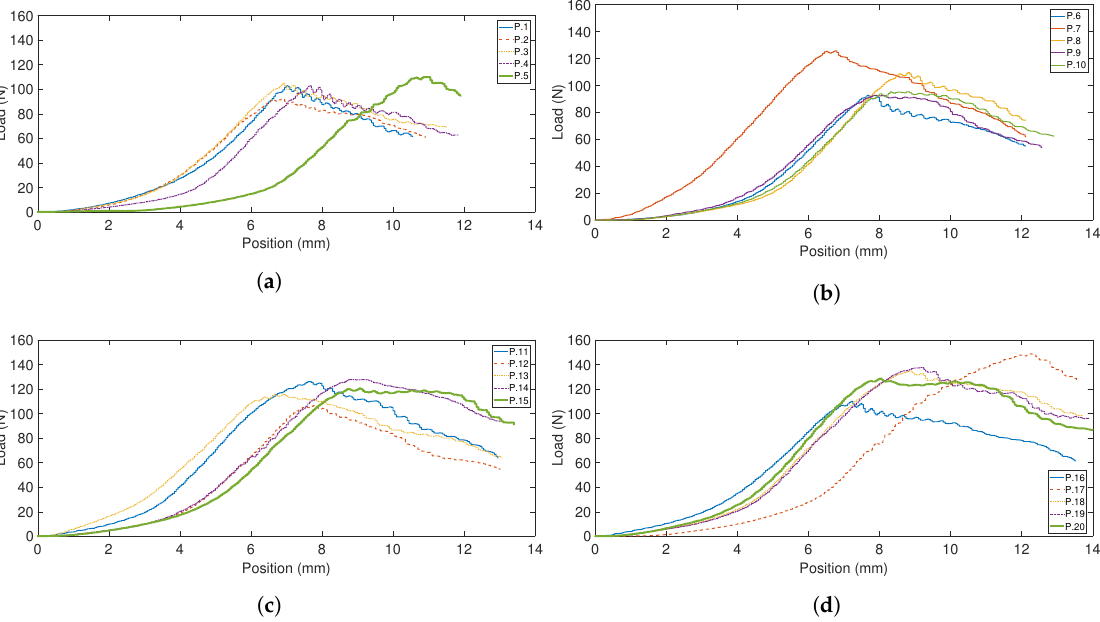
Figure 10. Position-load for a notched blade. Graphs are ordered from lower to higher diameter sizes and P indicates the sample number. ( a ) First quarter of peduncles tested. Sample diameters ranging from 8.56 to 9.95 mm. ( b ) Second quarter of peduncles tested. Sample diameters ranging from 10.11 to 10.94 mm. ( c ) Third quarter of peduncles tested. Sample diameters ranging from 10.96 to 11.42 mm. ( d ) Fourth quarter of peduncles tested. Sample diameters ranging from 11.55 to 12.37 mm.